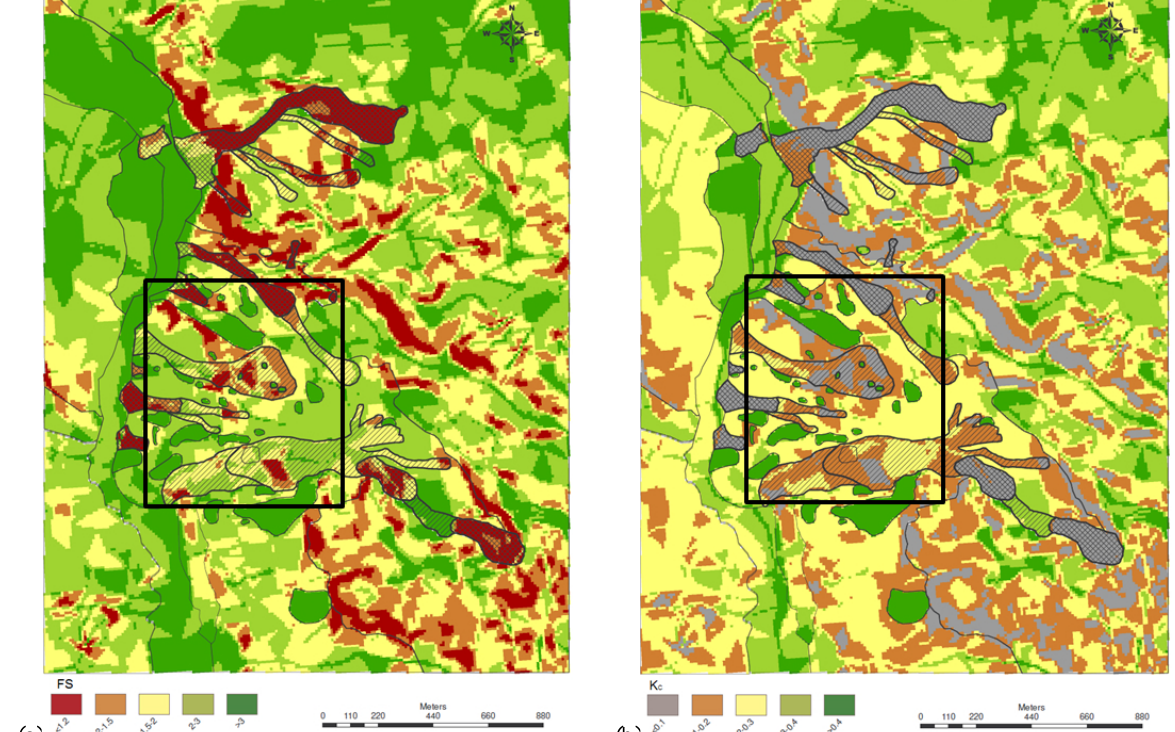
Fig. 6. (a) Safety factor map (FS) and (b) seismic critical coefficient ( k c ) map calculated for the ground water table level at half depth of the slip surface. The dark rectangle approximately indicates the urban